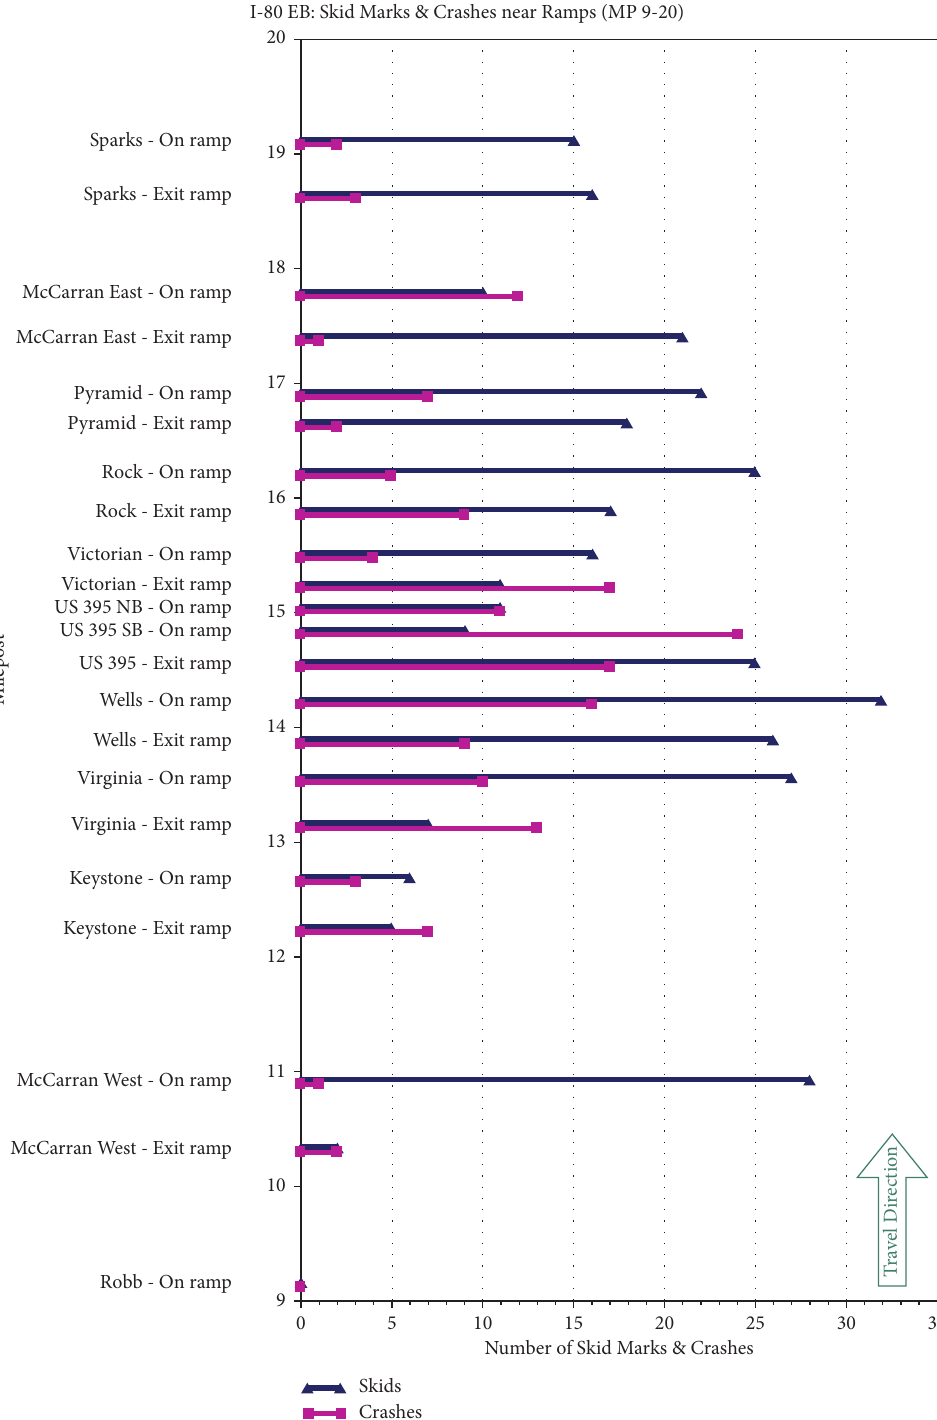
Figure 17: Crashes and skid marks at Interstate 80 eastbound